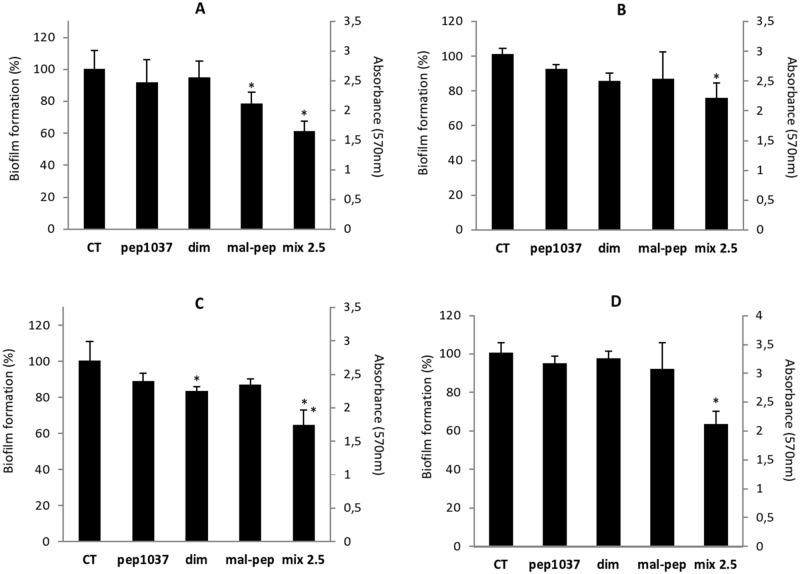
Inhibiting effect of 2.5 μg/mL of pep1037, cys-pep1037 dimer, mal-cys-pep1037 and a combination of pep1037 and cys-pep1037 dimer (denoted mix 2.5) on the formation of P. aeruginosa ATCC 15442 (A), P. aeruginosa ATCC 27853 (B), B. cenocepacia K56-2 (C) and B. cenocepacia J2315 (D) biofilms.Error bars indicate the standard deviation of six replicates, and statistical significance was determined using one-way ANOVA (*, P < 0.01 versus the control, denoted CT).